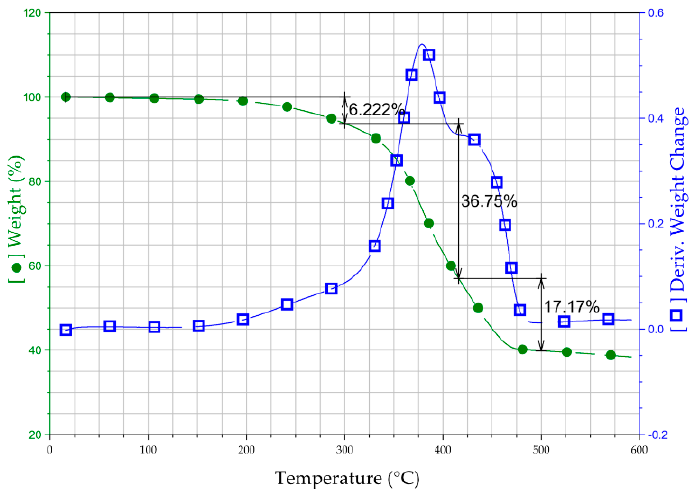
Figure 9. TGA chart and derivative thermo-gravimetric (DTG) of the as-received CRM.